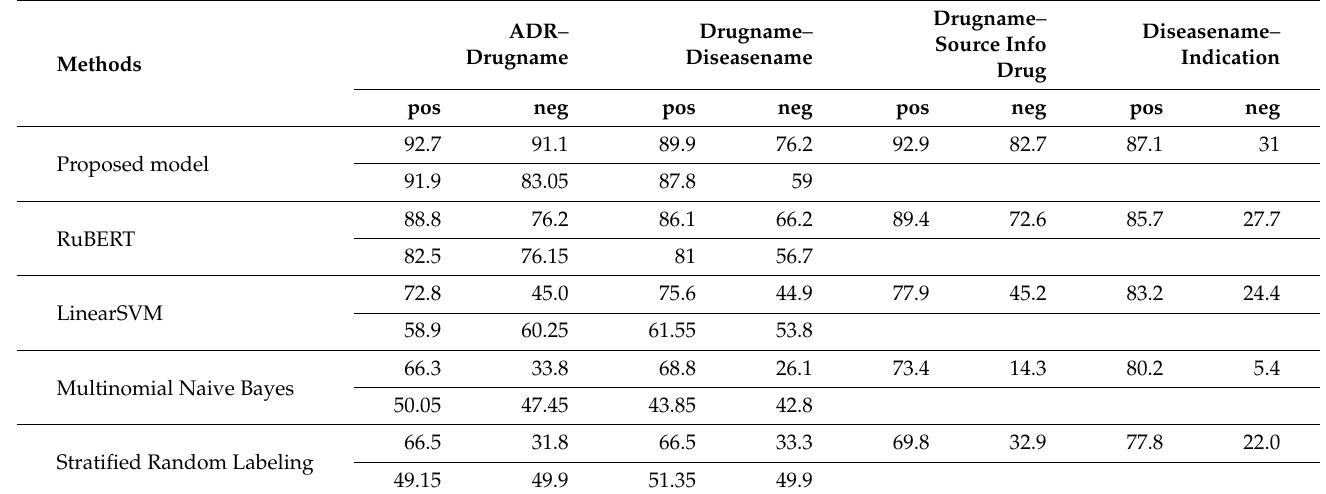
Table 6. Accuracy of predicting relations (pos) and absense of relations (neg) between entity pairs of different types in multicontext reviews from the RDRS